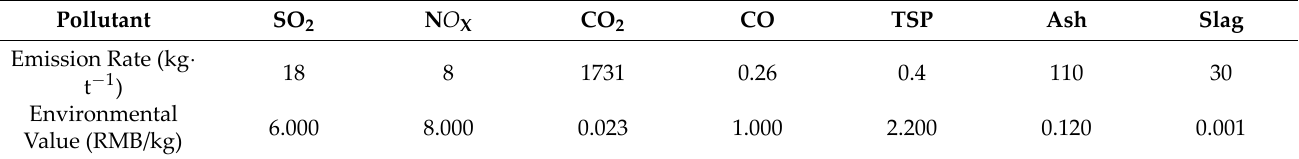
Table 2. Emission rate and environmental value of pollutant in coal‑fired power plant.